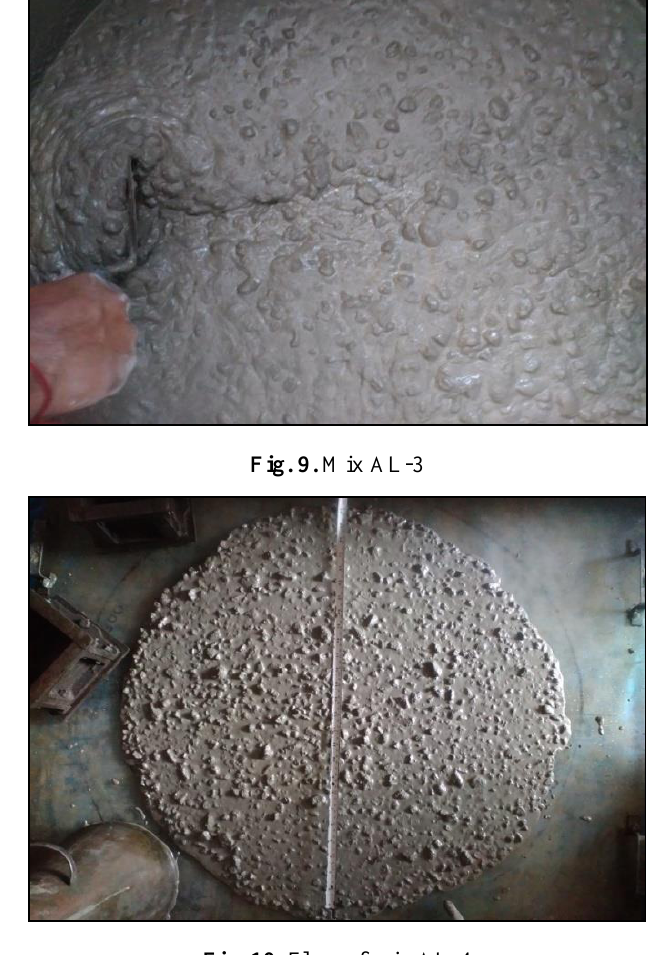
Fig. 10. Flow of mix